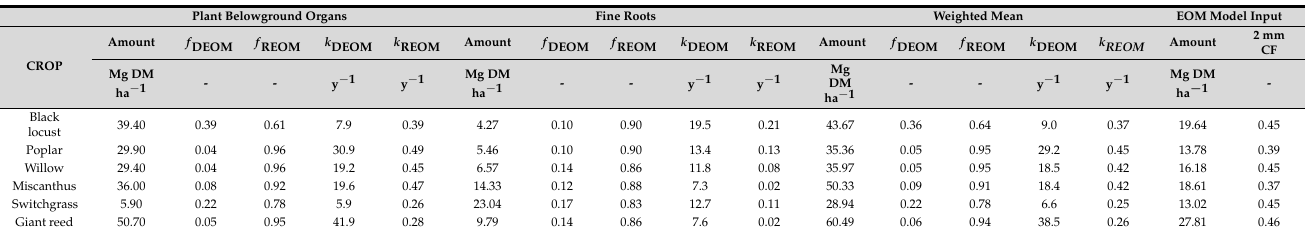
Table 1. Amount (Mg DM ha − 1 ) of exogenous organic matter (EOM) measured by Martani et al. [17] in the reversion layer (0–30 cm depth), RothC mean partitioning ( f ) and decay rate ( k ) for EOM types (FR: Fine roots and PBO: Plant belowground organs) of six different perennial biomass crops calculated by Ferrarini et al. [22], scaled-weighted mean and 2-mm sized residues that have been used in the ECOSSE model by applying the correction factor